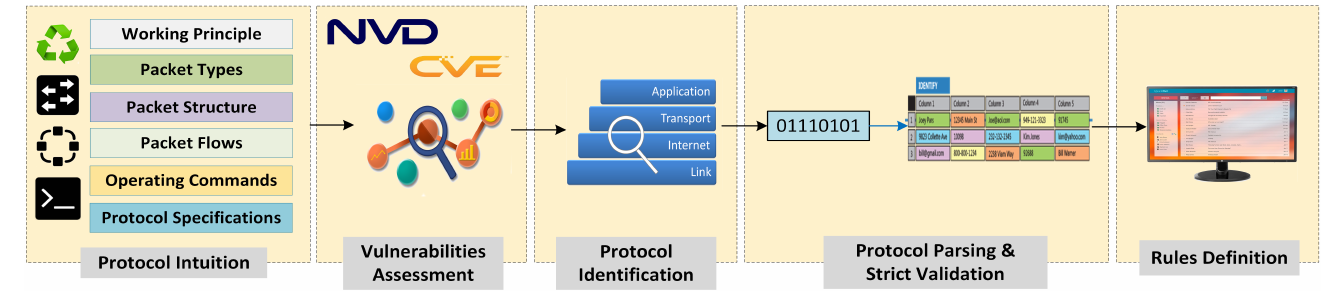
Figure 3. Proposed methodology for protecting the protocol-based vulnerabilities in an IoT